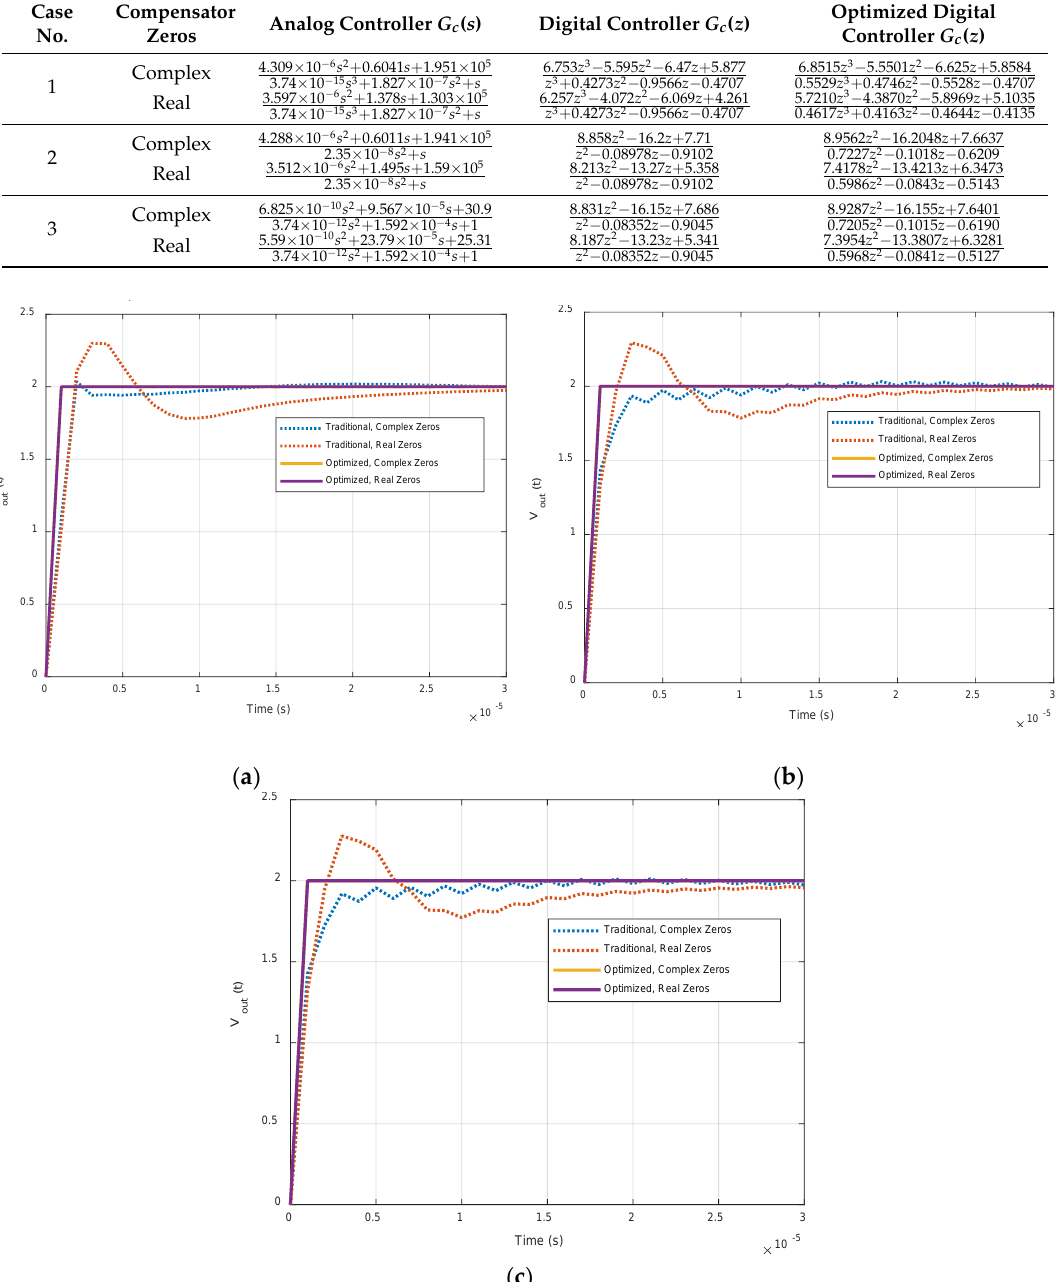
Figure 9. Load transient response.